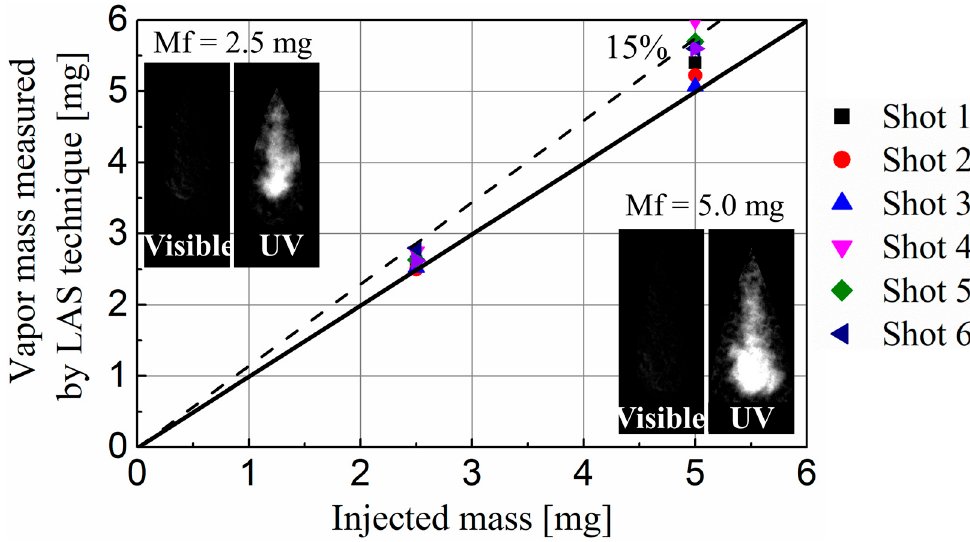
Figure 6. Comparison of vapor mass measured by the C-LAS technique to injected fuel mass (T a = 800 K, P a = 4.8 MPa, P inj = 100 MPa, M f = 2.5, 5.0 mg).